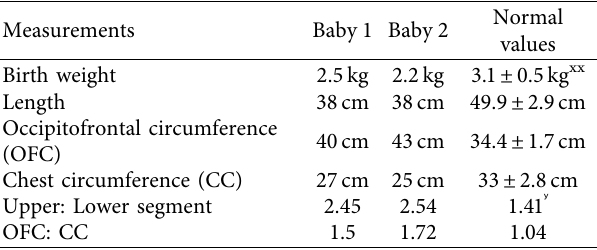
Table 2: Anthropometry of babies 1 and 2.